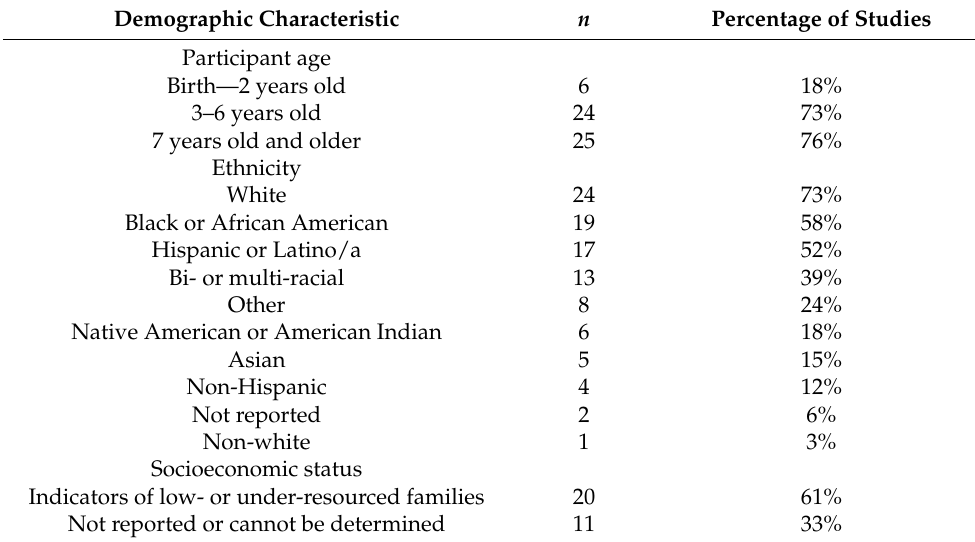
Table 1. Participant Demographics Across Research